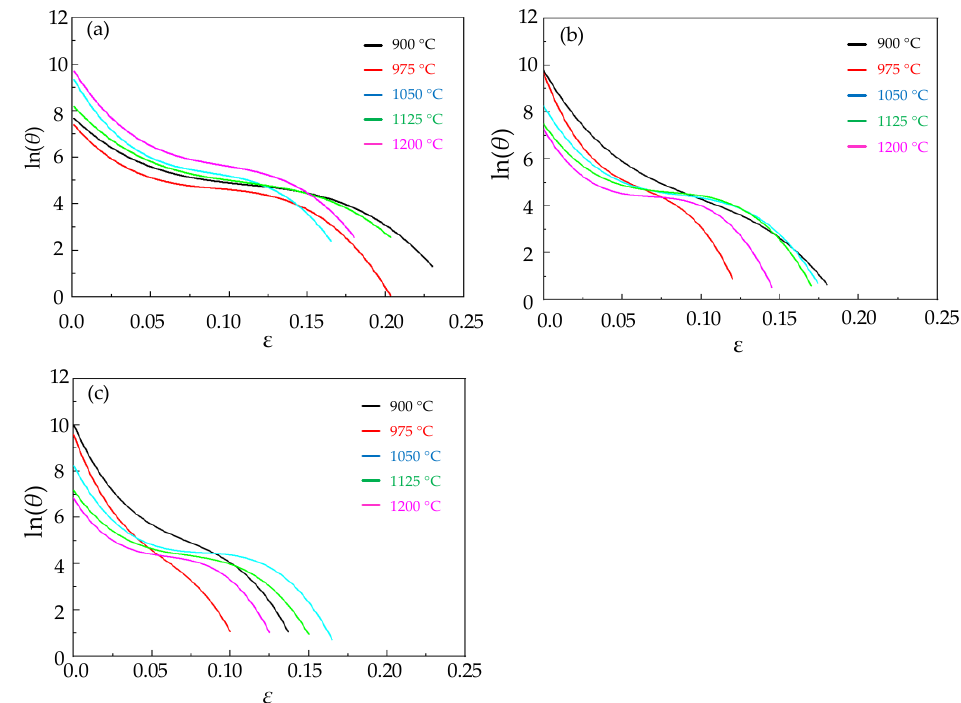
Figure 3. The relationship map of ln ( θ ) − ε under different temperatures and strain rates: ( a ) ε = 0.1 s − 1 ; ( b ) ε = 0.01 s − 1 ; ( c ) ε = 0.005 s − 1 .